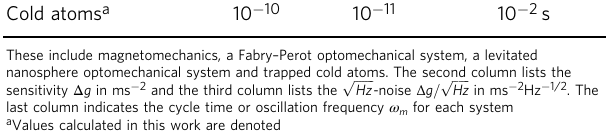
a Values calculated in this work are denoted